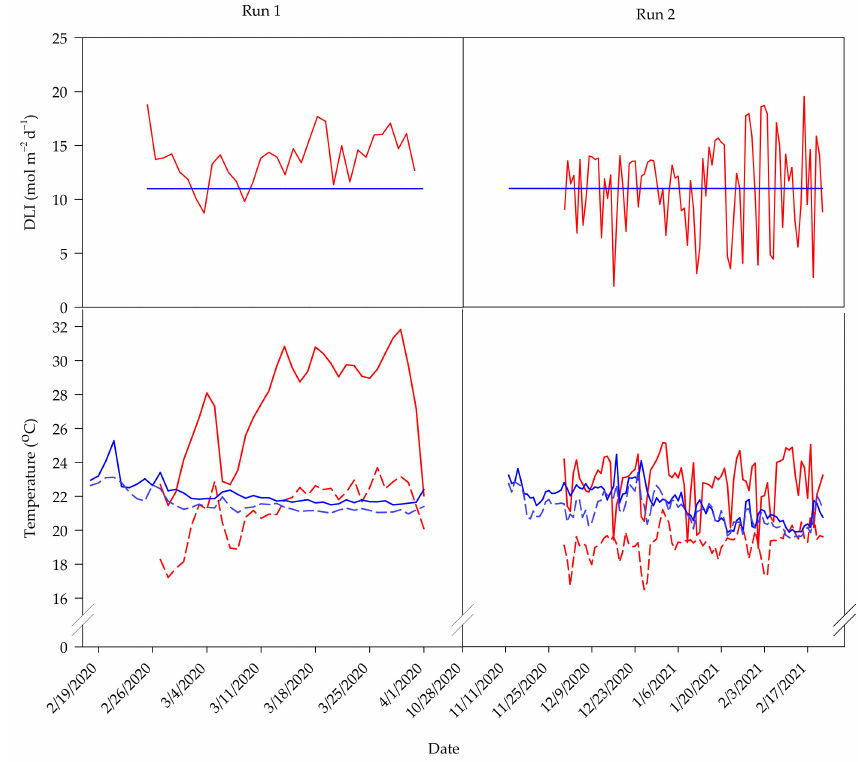
Figure 1. Average daily light integral (DLI) and temperature of the greenhouse (red lines) and indoor (blue lines) environments in the first and second experimental runs. In the temperature graphs, solid and dashed lines indicate the average data collected during the day and night,